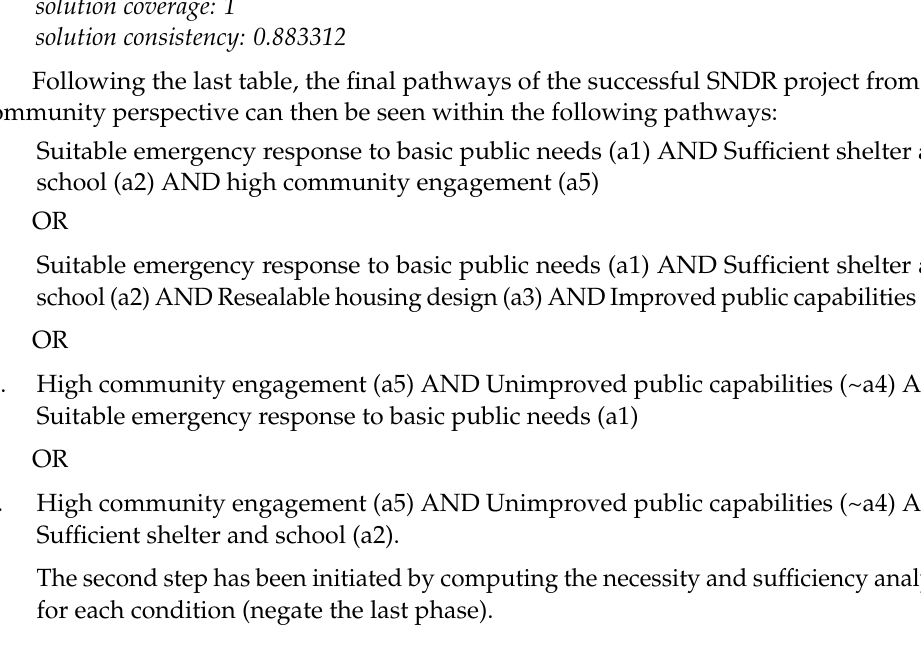
Table A17. Necessity and sufficiency analysis of conditions (~ultimate goal).